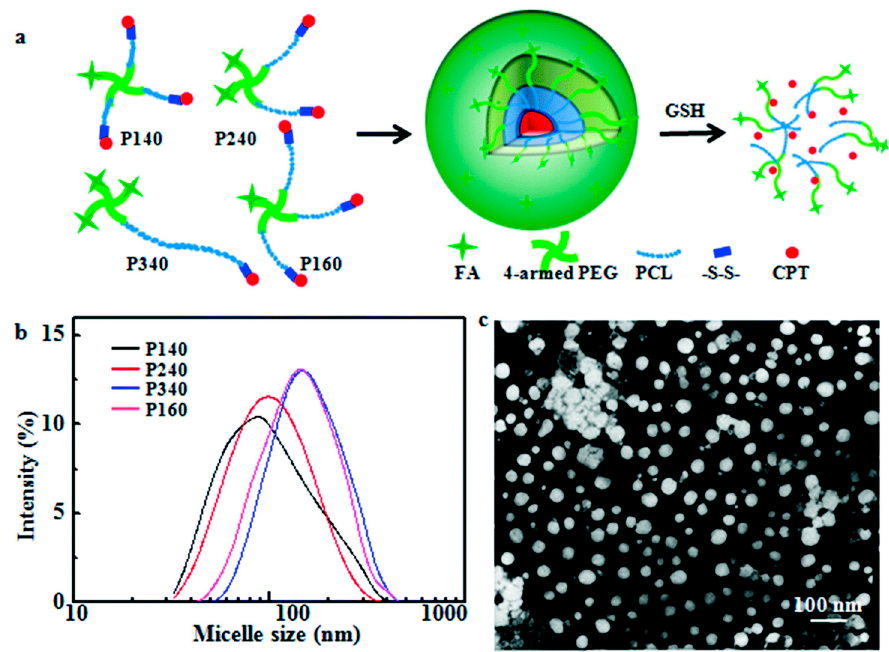
Figure 10. ( a ) Scheme of A(AB) 3 (P140, P160), A 2 (AB) 2 (P240), and A 3 (AB) (P340) assembly into